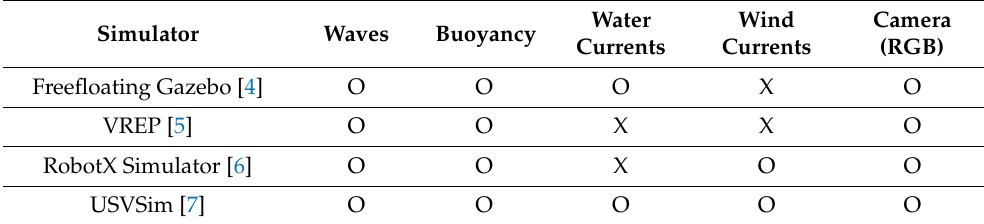
Table 1. Existing simulators for autonomous